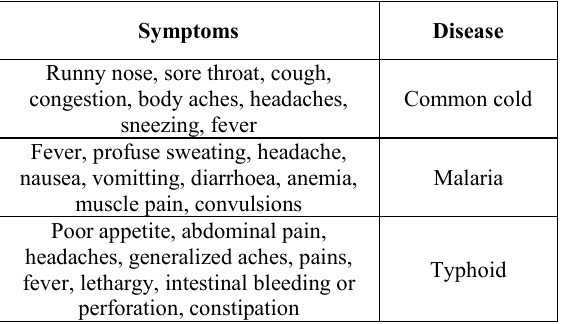
Table 1. Sample dataset with symptoms with the diseases Symptoms